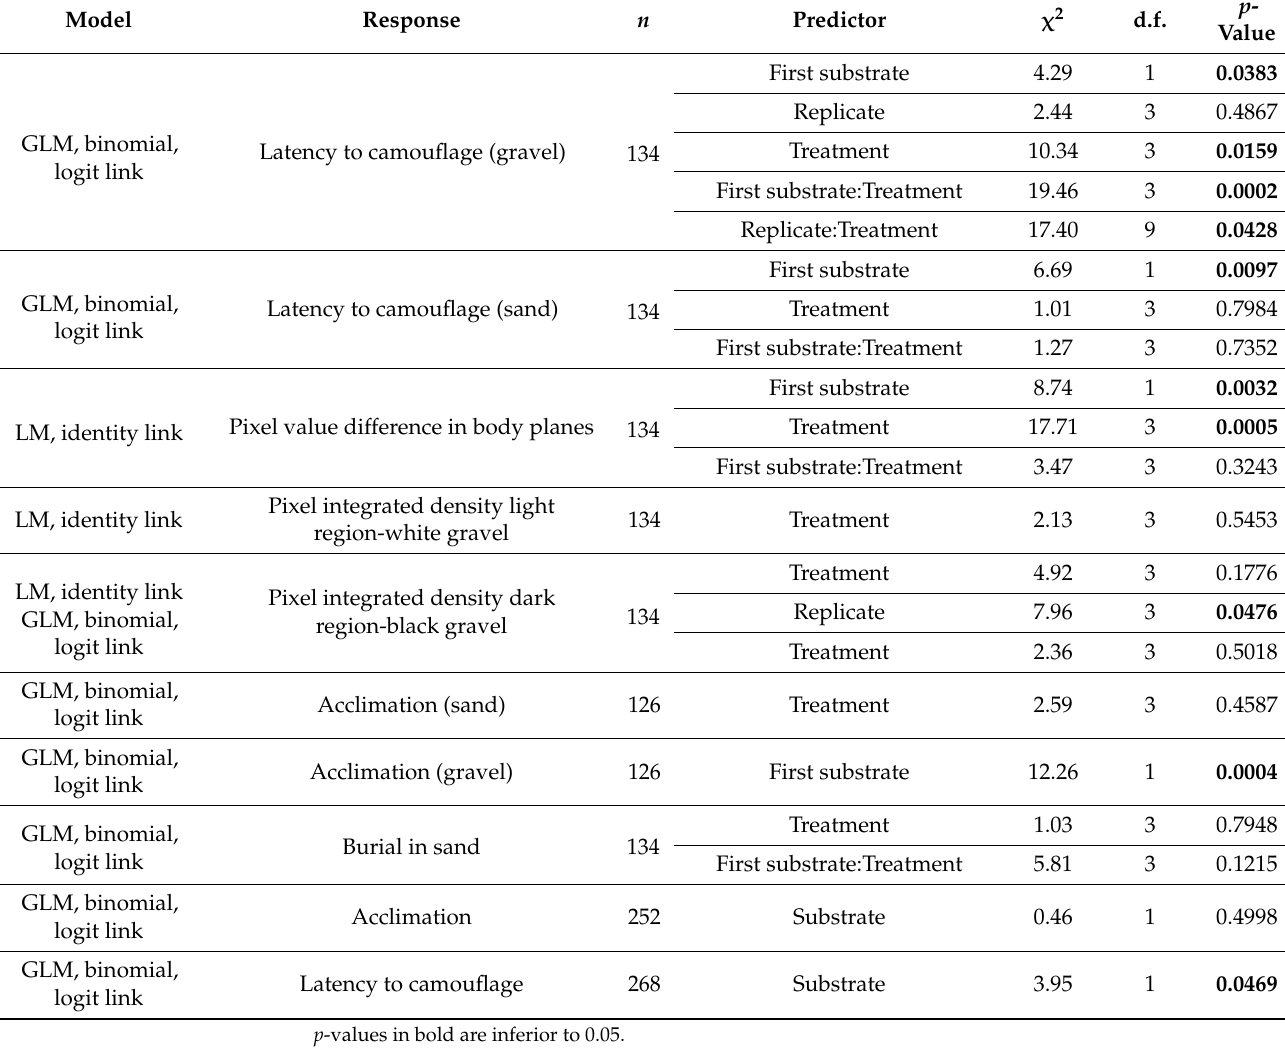
Table 3. Results from statistical analyses, depicting the effect of the treatments (control, acidification, warming, and acidification and warming combined) on the ability to camouflage of Sepia officinalis .